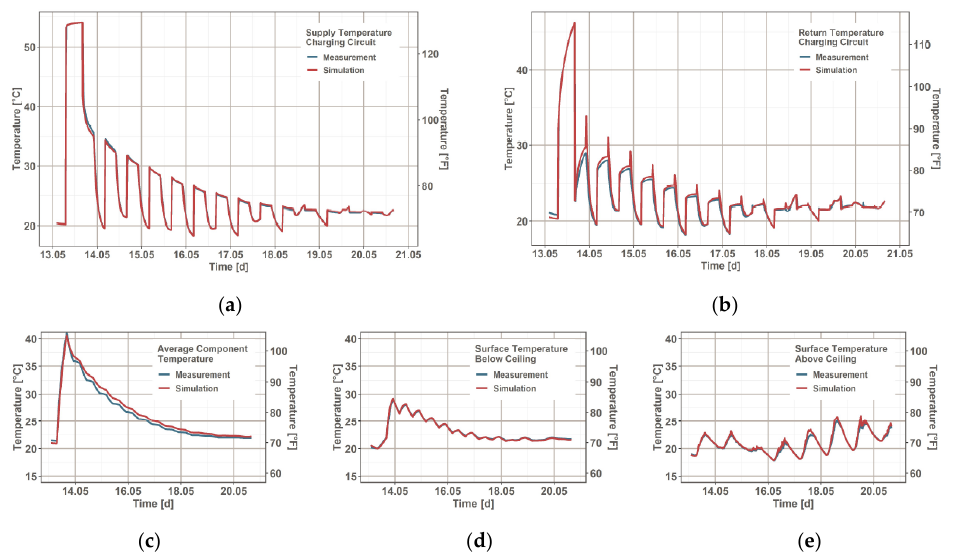
Figure 9. Comparison between measurement and simulation of supply ( a ) and return ( b ) tempera- tures in the TABS in the concrete core of the ceiling. Comparison of component average temperature ( c ), surface temperature below ( d ) and above ( e ) the ceiling, and the 3D object coupled with the TABS model inside. Table 2. Statistical indices of comparing the simulation to the temperature measurement of a single example case on the ceiling TABS storage for new buildings.